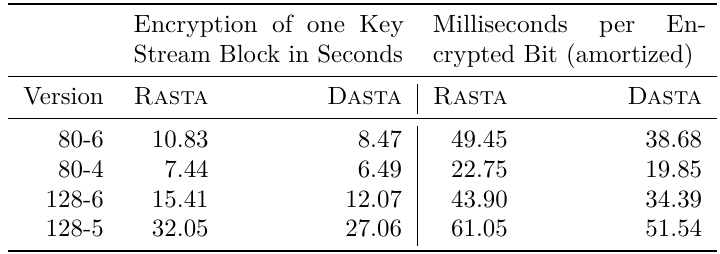
Table 4: Performance comparison of Rasta and Dasta in the homomorphic key stream generation with the HElib [HS13] on Intel(R) Xeon(R) CPU E3-1230 v6 @ 3.50GHz with 32GB of